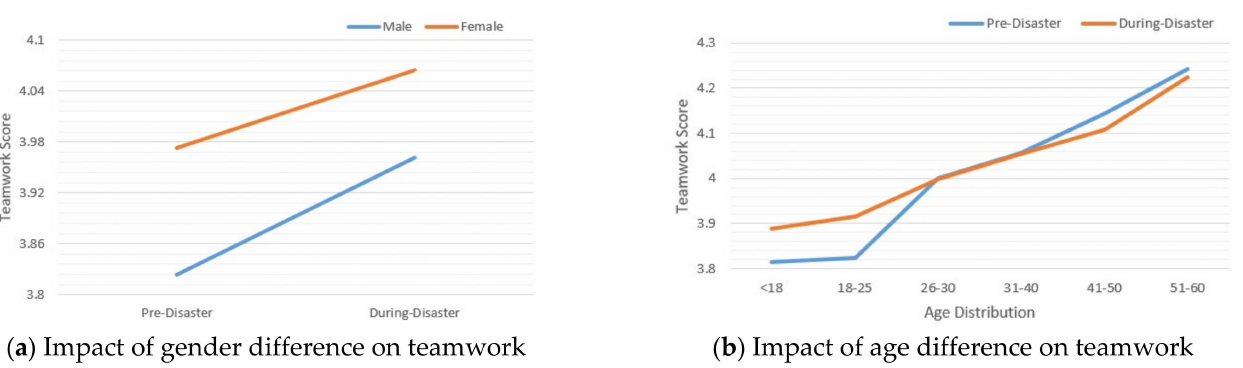
Figure 2. The impacts of demographic variables (gender and age) on teamwork. ( a ) The impact of gender difference on teamwork. ( b ) The impact of age difference on teamwork. The y -axis represents the average score of teamwork for each group, valued in